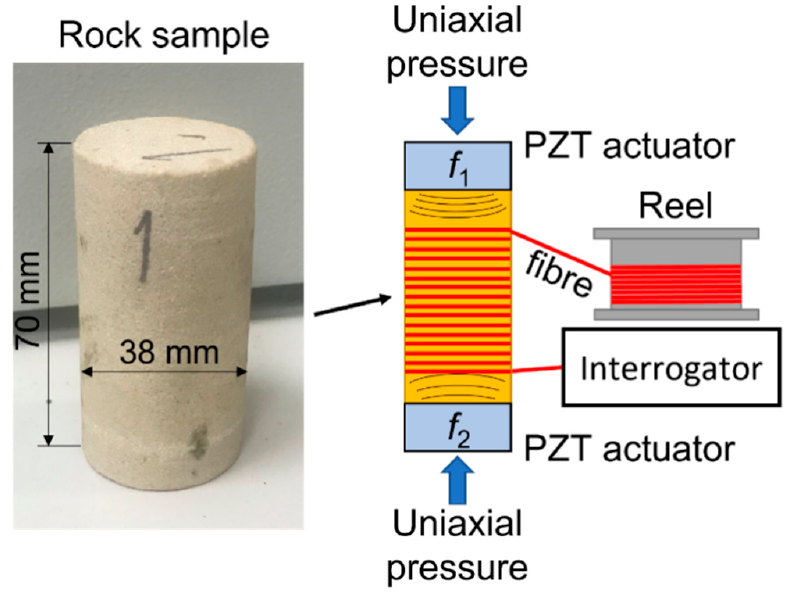
Figure 9. Schematic of the laboratory setup.